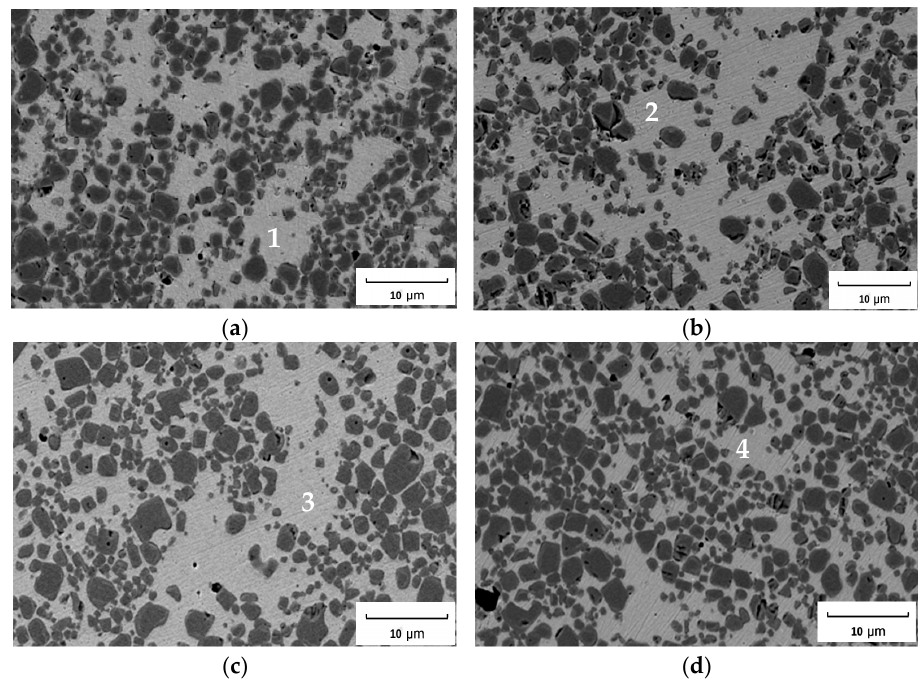
Figure 2. Thermal cycle of Gleeble simulation.